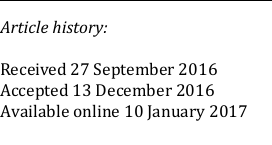
: Map of Miri showing the location of study area area 3. METHODOLOGY